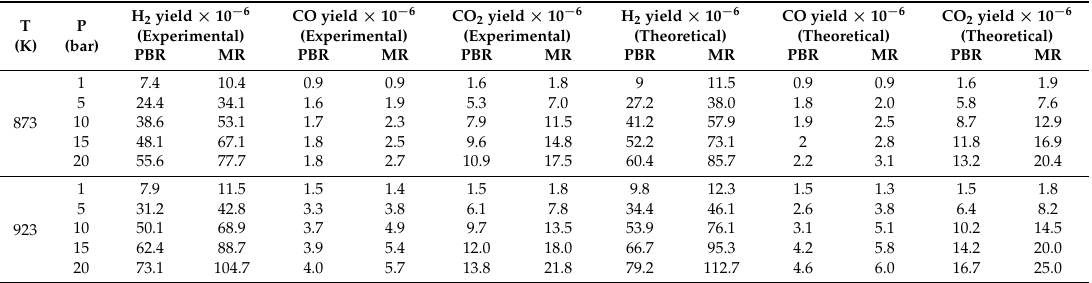
Table 6. Estimation of product Yields by 2-D model versus experimental data. With permission to reprint from Elsevier by Oyama and Hacarlioglu